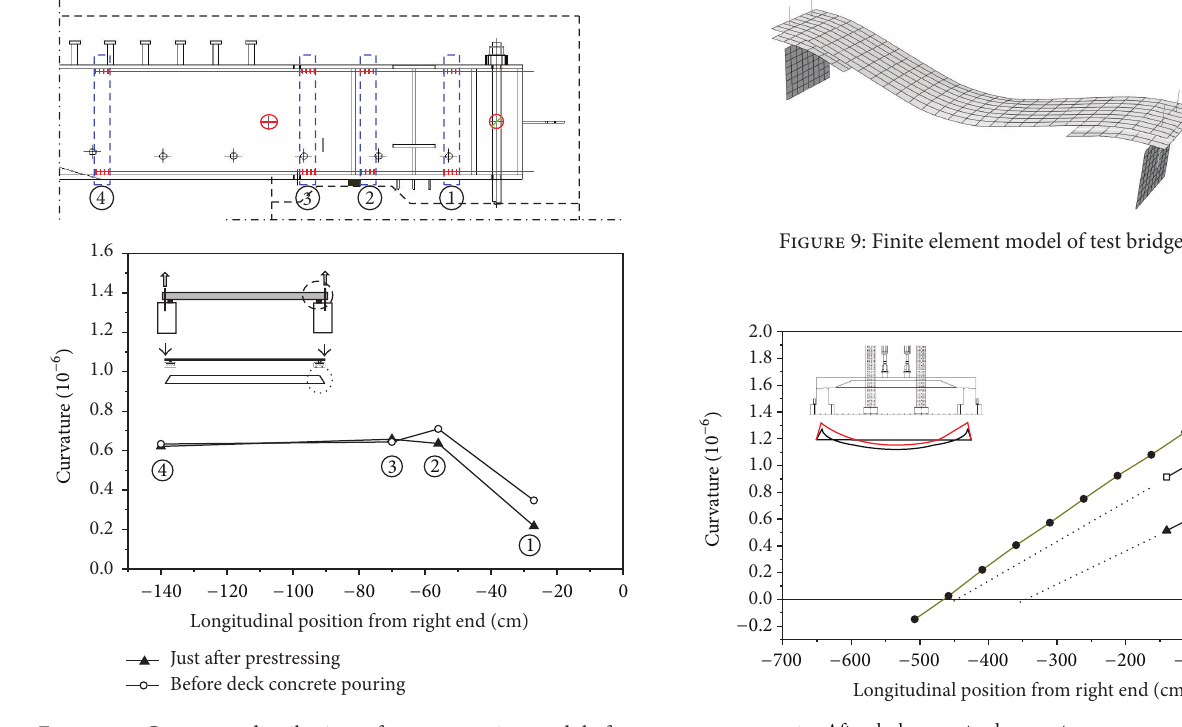
Figure 7: Curvature distribution after prestressing and before concrete pouring.